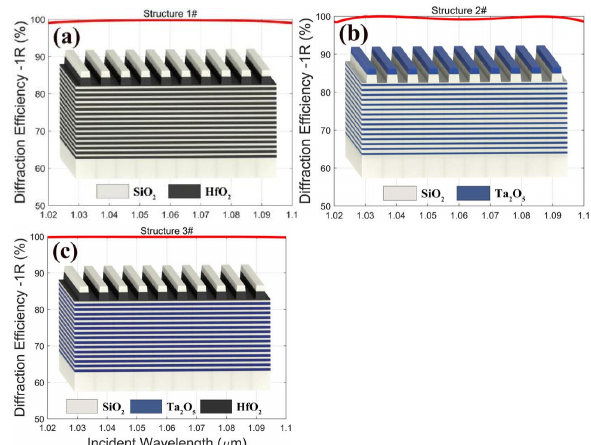
Figure 17. Different grating designs in the 1020–1100 nm band: ( a ) − 1st di ff raction e ffi ciency = 99.57%, ( b ) − 1st di ff raction e ffi ciency = 99.23%, and ( c ) − 1st di ff raction e ffi ciency = 99.89%.